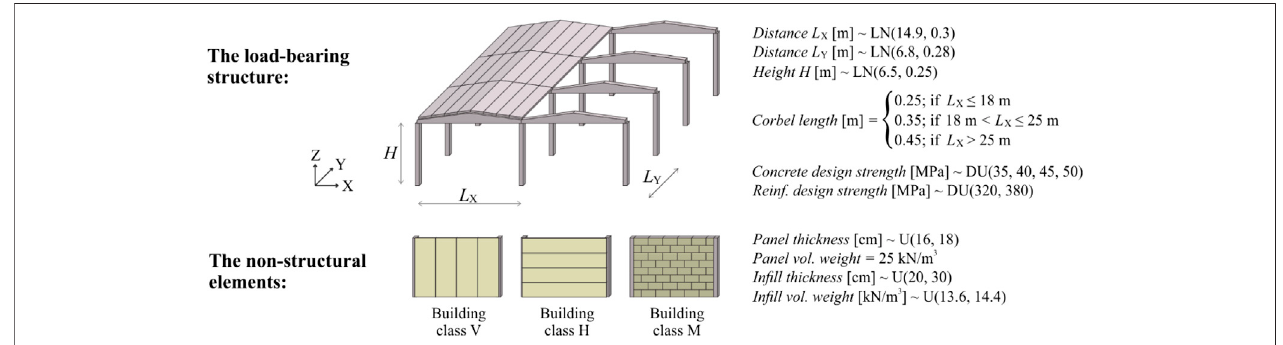
FIGURE 10 | The model of the load-bearing structure (left) and the force-displacement (moment-rotation) relationship of the non-linear elements employed in the model (right).